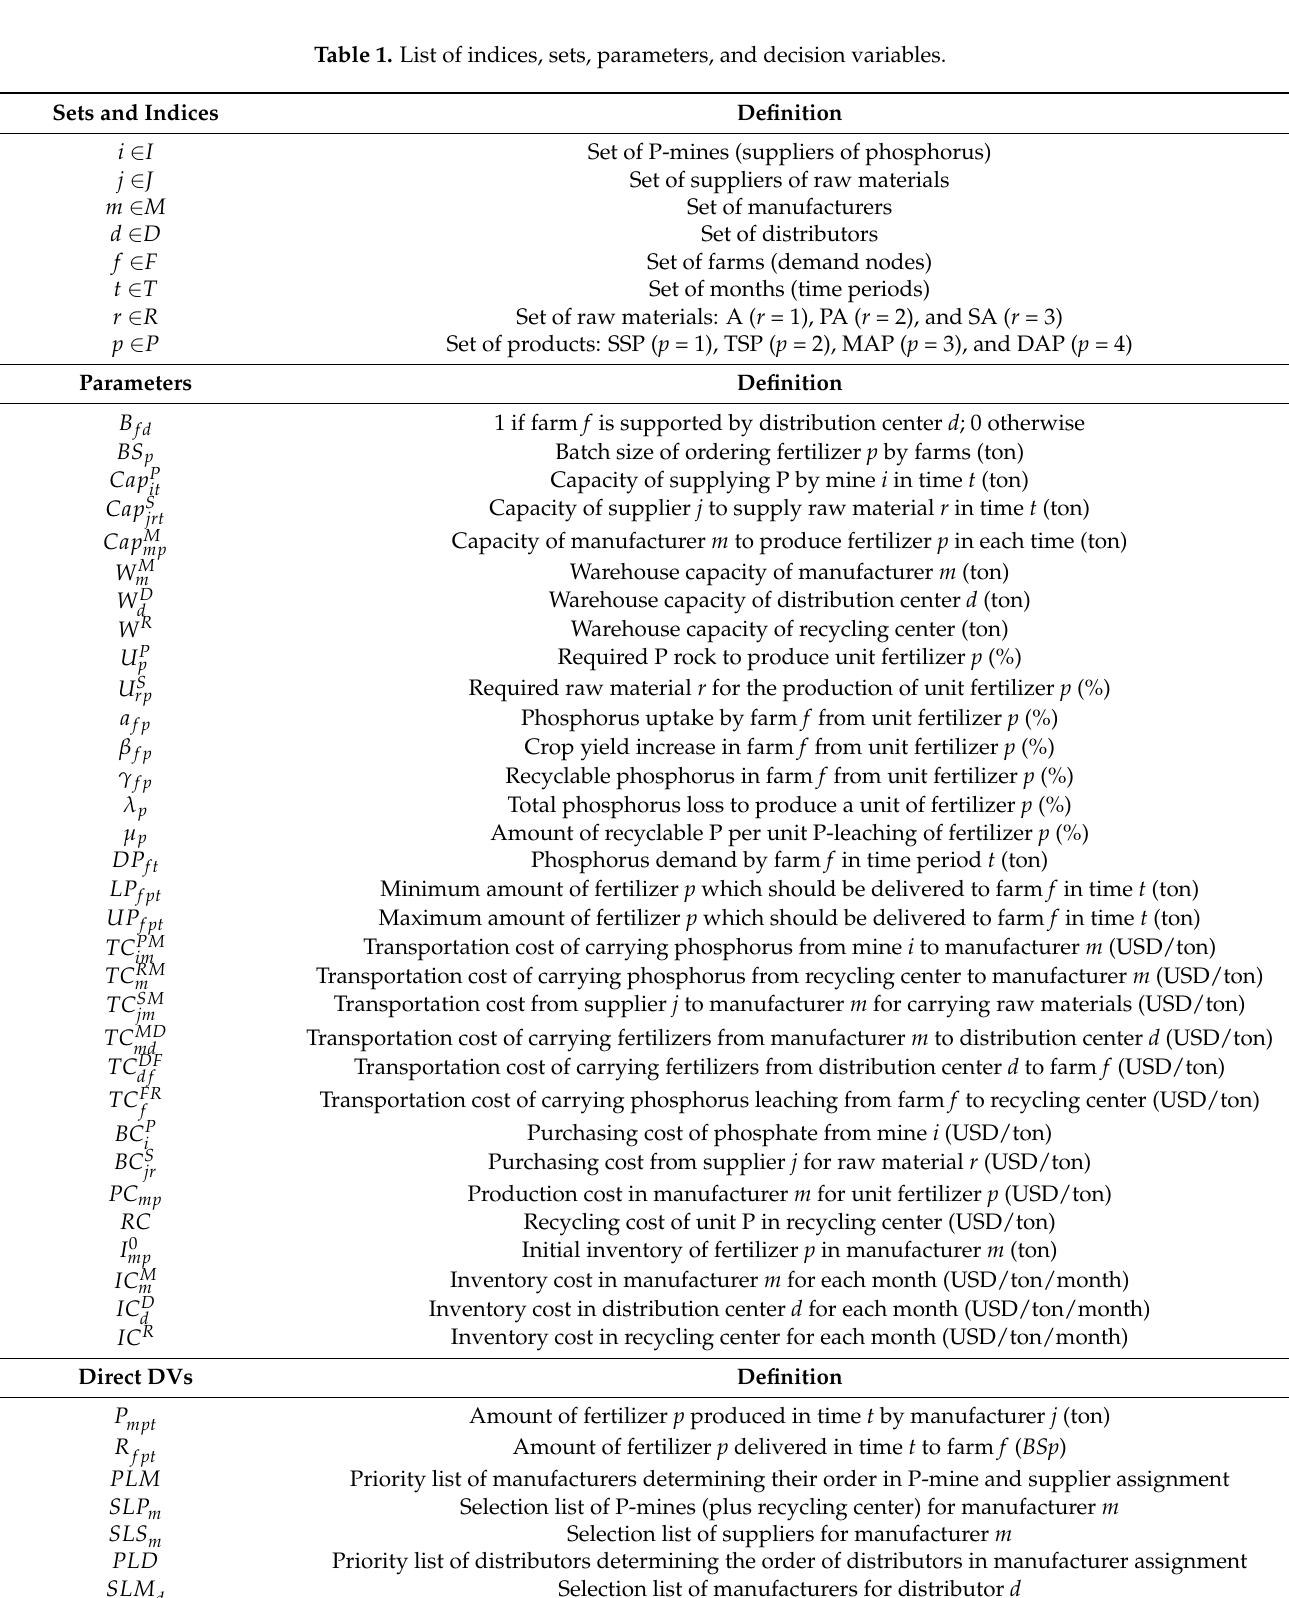
Table 1. List of indices, sets, parameters, and decision